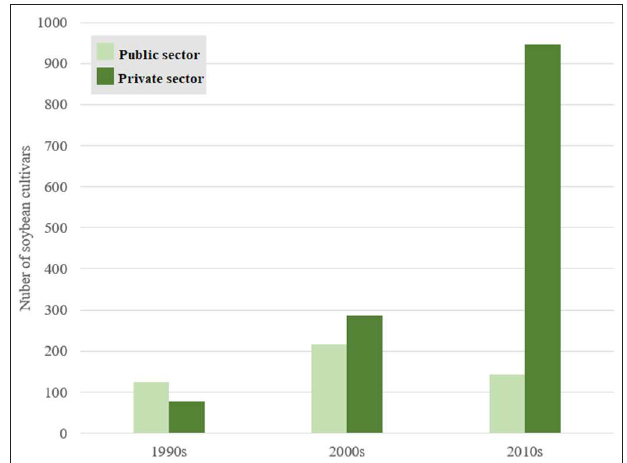
FIGURE 3 | Share of soybean cultivars registered by the Brazilian Ministry of Agriculture (CULTIVARWEB: http://sistemas.agricultura.gov.br/snpc/